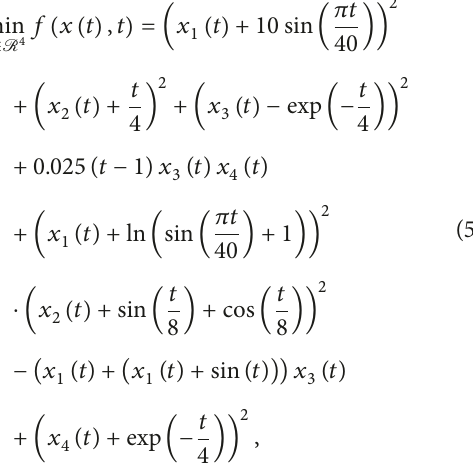
model (18) (denoted by DTZNN-I) for TVNO and compared with the one-step DTZNN model (14) (denoted by